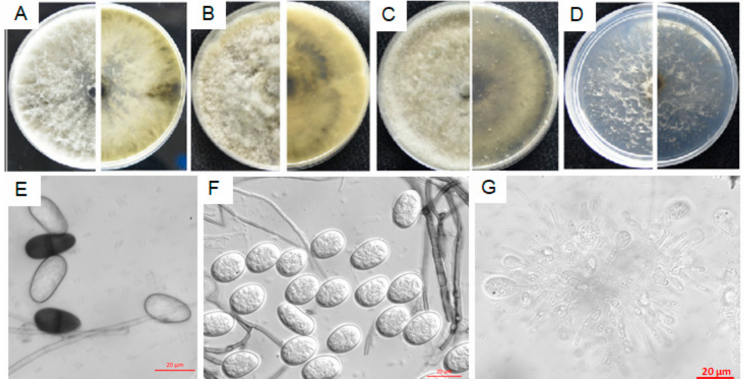
Figure 6. Morphological characteristics of Lasiodiplodia theobromae isolate L3. ( A – D ) The front and back of the colony morphology on PDA, MEA, OA and WA plate; ( E ), young (transparent) and mature (dark) conidia with one septum, induced by ultraviolet radiation for 7 days on bayberry twigs on WA plates; ( F ), transparent young conidia; ( G ), pycnidium. Fungal mycelia and spores were observed and photographed with a Zeiss Axio observer Z1 Microscope (Carl Zeiss Microscopy,